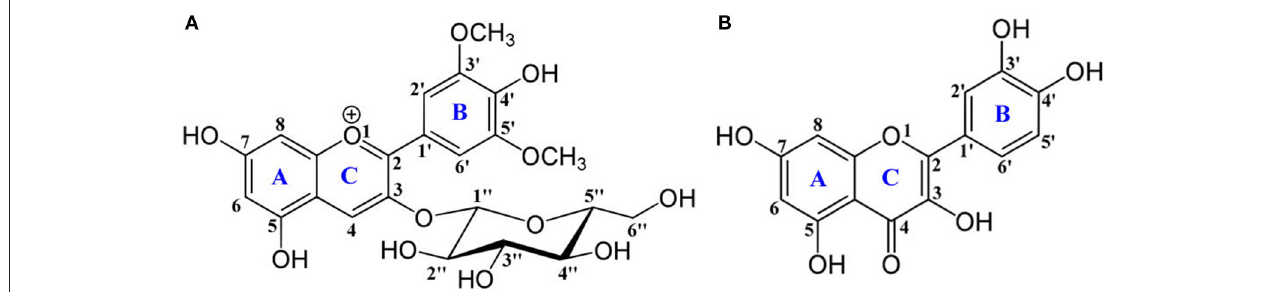
Figure S2. π - π stacking, namely ring-stacking (see Table 1 ), phenomenon is universal for all stable conformers (Di Meo et al., 2012). The stacking form includes translated parallel ( 10 , 12 ), also called “parallel-displaced” ( Di Meo et al., 2012), rotated parallel ( 1 , 4 , 5 , 9 ), antiparallel ( 2 , 3 , 6 , 7 , 8 , 11 ) and aslant parallel ( 2 , 5 , 8 , 10 , 11 , 12 ) that has a stacking dihedral bigger than 10 ◦ . Among them, rotated and aslant parallel forms are rarely reported before. The distance and dihedral for antiparallel stacking rings are 3.3 ∼ 3.4 Å and 0.5 ∼ 7.0 ◦ , respectively, while for aslant parallel stacking rings are 3.0 ∼ 4.1 Å and 12.1 ∼ 27.9 ◦ , respectively. The absent ( 1 , 3 , 6 , 11 ), displaced ( 1 , 2 , 3 , 4 , 6 , 8 , 9 , 11 ), or aslant ( 2 , 8 , 10 , 11 , 12 ) stacking of any ring tends to reduce the strength of stacking, and thus reduce the stability of the complex.